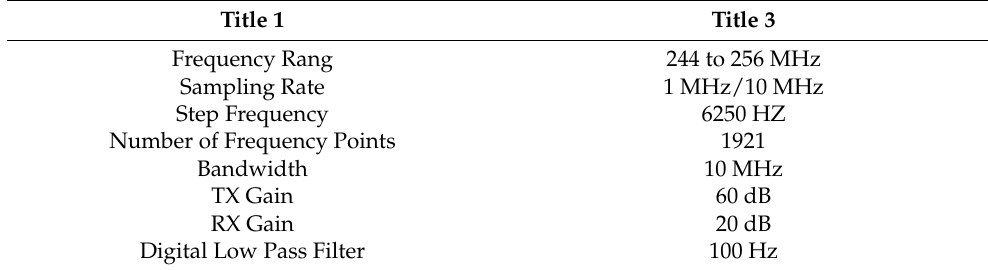
Table 2. LimeSDR − mini parameters